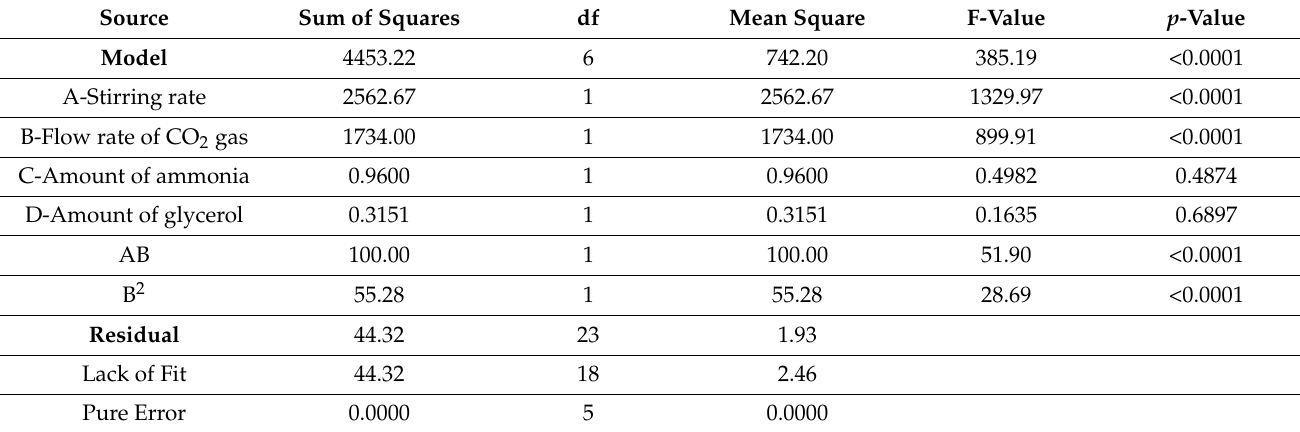
Table 9. ANOVA analysis table for response 2: CaCO 3